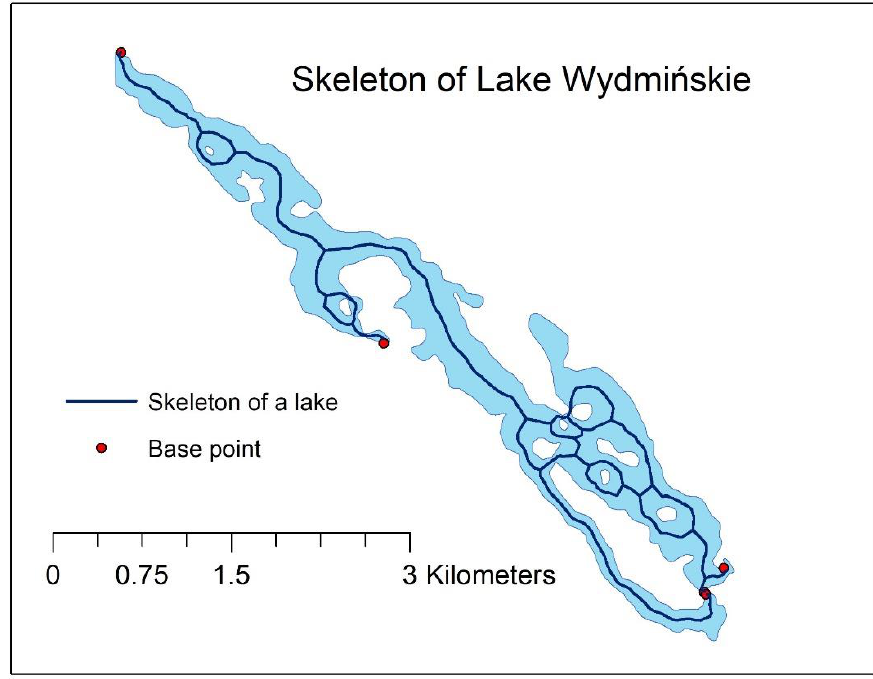
Figure 29. A model of the network skeleton generated in a geometrically complex polygon representing Lake Wydmińskie based on the adopted set of base points, after loop elimination and two iterations of the smoothing procedure to remove zigzag effects.